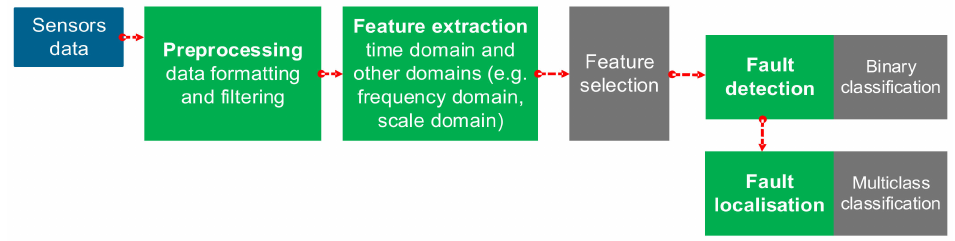
Figure 7. General structure of a data-driven fault detection and localisation